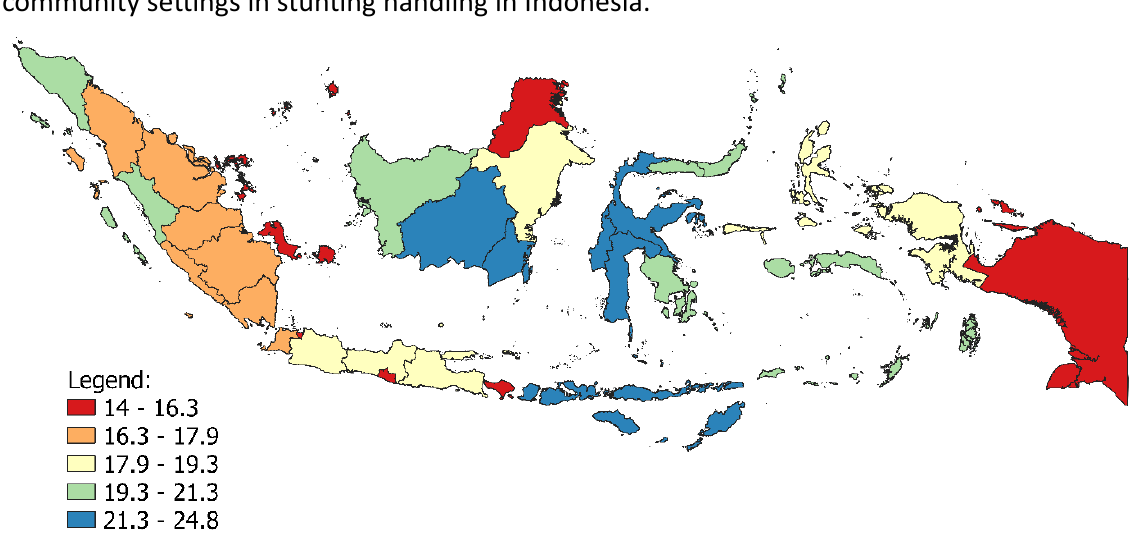
Figure 2: The Average Distribution of the Prevalence of Stunting in 34 Provinces in Indonesia, 2010-2018